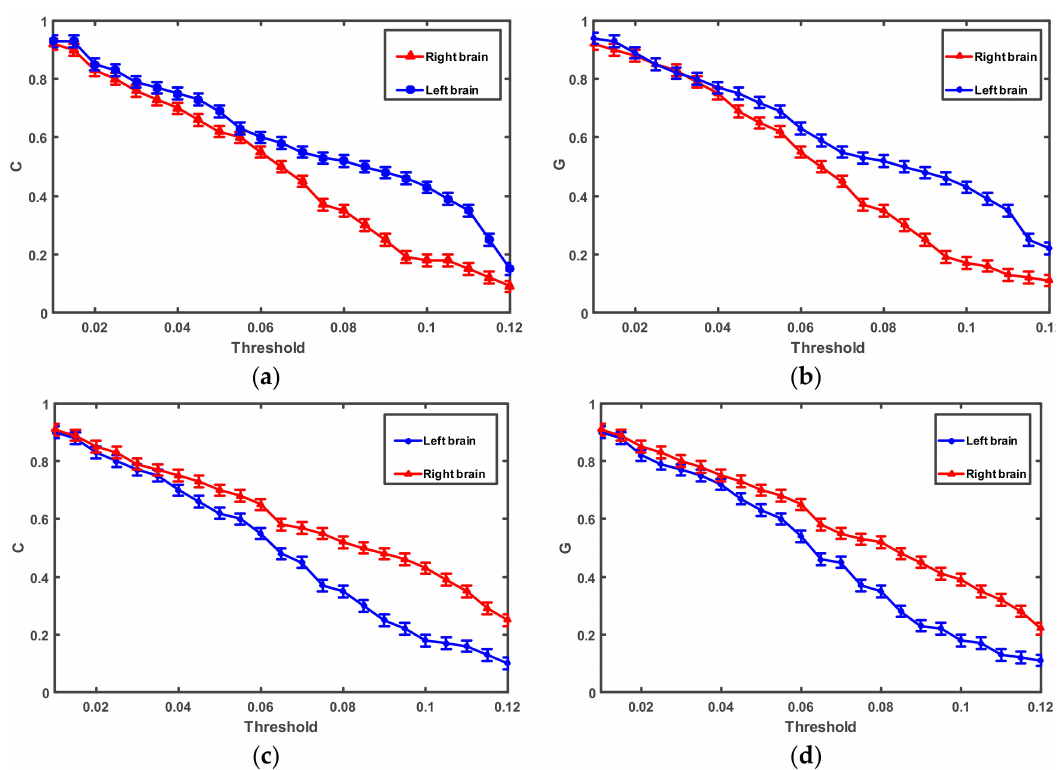
Figure 4. ( a ) Mean clustering coefficient (C) as a threshold when moved to the right; ( b ) mean global efficiency (G) as a threshold when moved to the right; ( c ) mean C as a threshold when moved to the left; ( d ) mean G as a threshold when moved to the